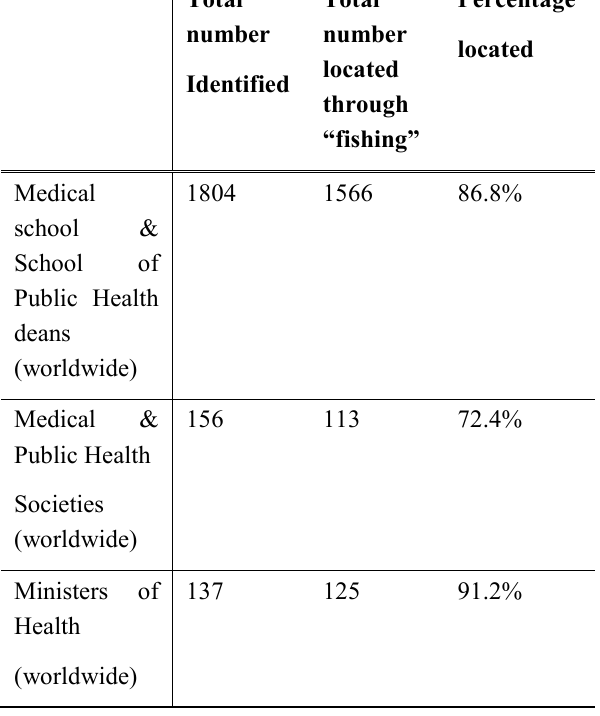
Table 1: Results of